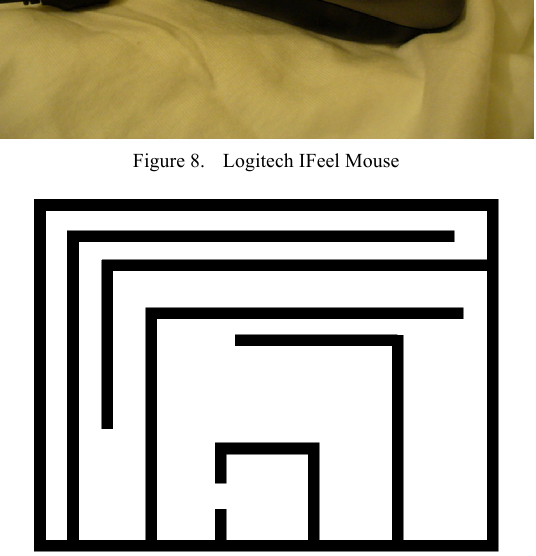
Figure 9. Simulated Robot Maze